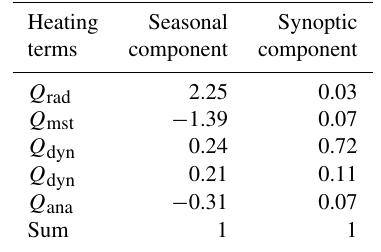
Table 2. Fractional contribution of the individual heating terms in Fig. 7b to their sum for θ e = 300K. The analysis is done separately on synoptic and seasonal components. The seasonal component is based on a two-harmonic fit, and the synoptic component is defined as the residual. The fractional contributions sum to 1, while a pos- itive contribution means in phase and negative contribution means anti-phase. A contribution of an absolute value that is bigger than 1 illustrates that the variability in the heating term is larger than the variability in the sum on the corresponding